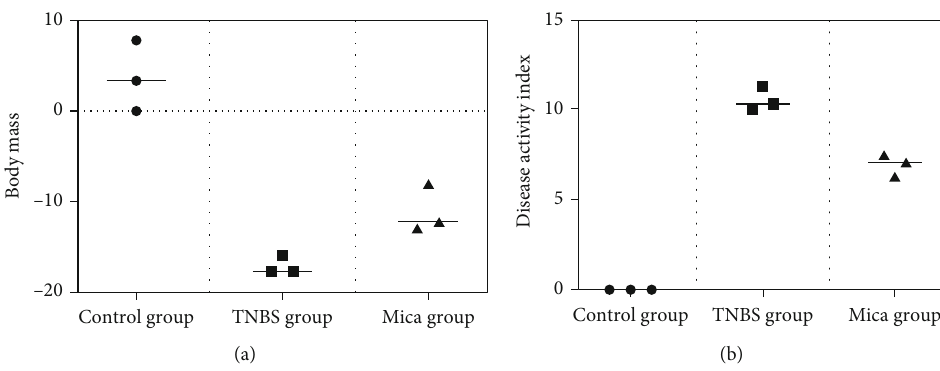
Figure 1: (a) Weight loss in each group and (b) disease activity index in each group. Table 4: Weight loss (%).